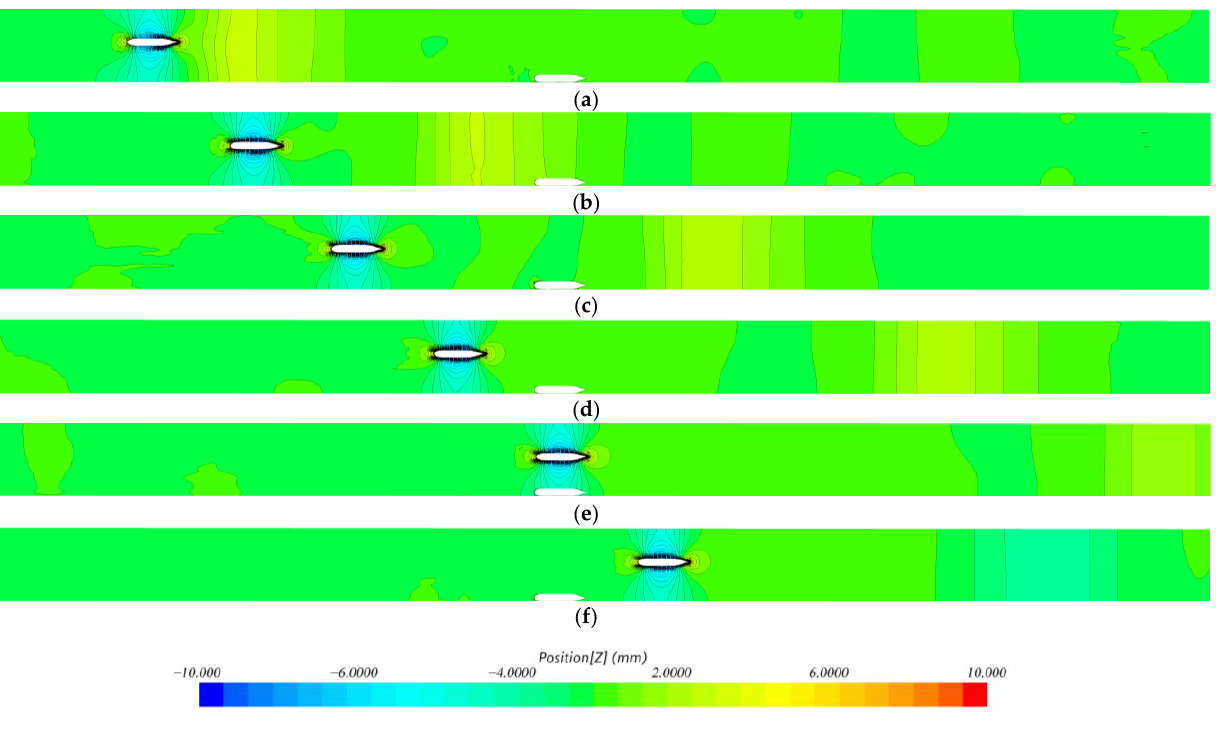
Figure 7. Snapshots of wave patterns (linear acceleration). ( a ) ξ = − 8, ( b ) ξ = − 6, ( c ) ξ = − 4, ( d ) ξ = − 2, ( e ) ξ = 0, ( f ) ξ = 2.